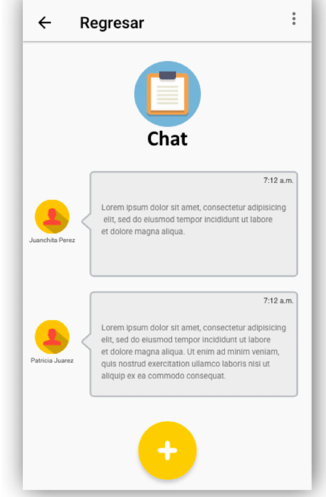
Figure 6. Chat to communicate with